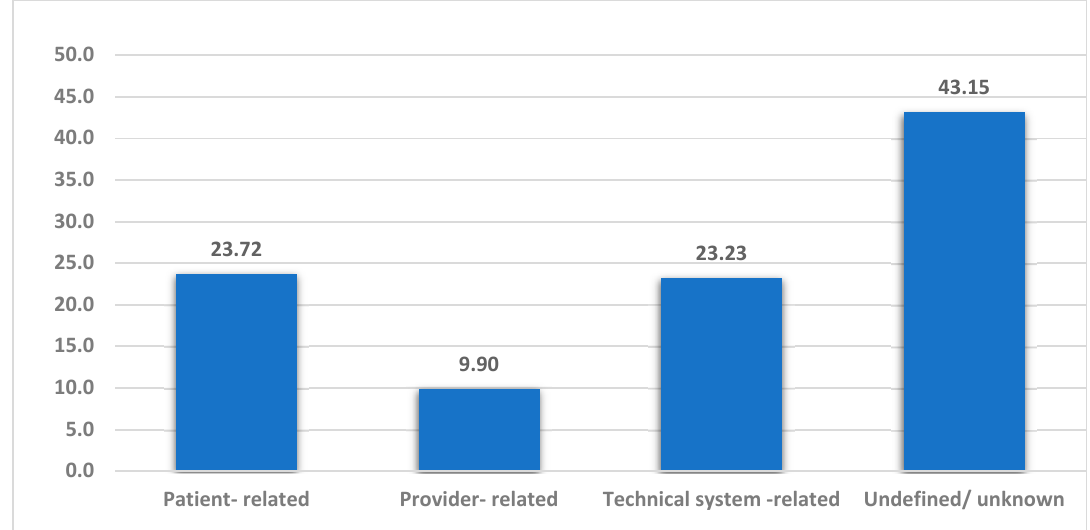
Figure 2. Reasons for canceled telehealth visits at DHA, March 2020–July 2021 (%).